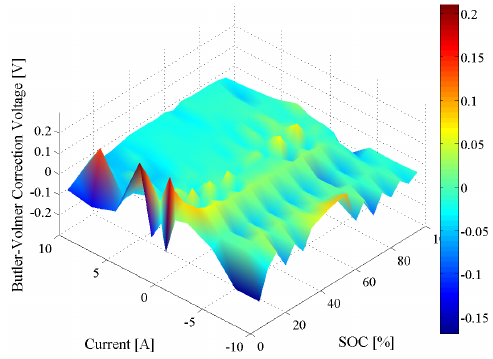
Figure 17. Dependence of the voltage correction factor on the SOC and current for T = 25 °C.